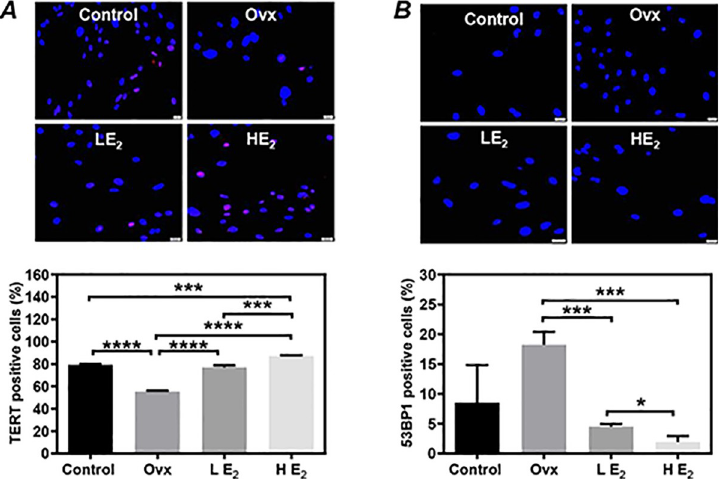
Fig 4. The telomerase activity and DNA damage of cardiac stem cells (CSCs). The telomerase activity and DNA damage in twice-passaged CSCs were evaluated by immunostaining analysis on the expression of TERT (A) and 53BP1 (B) , respectively. Representative images (upper) and quantitative data (lower) are shown. The nuclei were labeled with DAPI. Scale bar: 20 μ m. Control: sham-operated mice, Ovx: ovariectomized mice, LE 2 : ovariectomized mice received a low dose of 17 β -estradiol (0.01 mg/60 days), HE 2 : ovariectomized mice received a high dose of 17 β -estradiol (0.18 mg/ 60 days). All data are mean ± SD from 3 independent experiments (n = 3 for each group). � P < 0.05, ��� P < 0.001, ���� P <